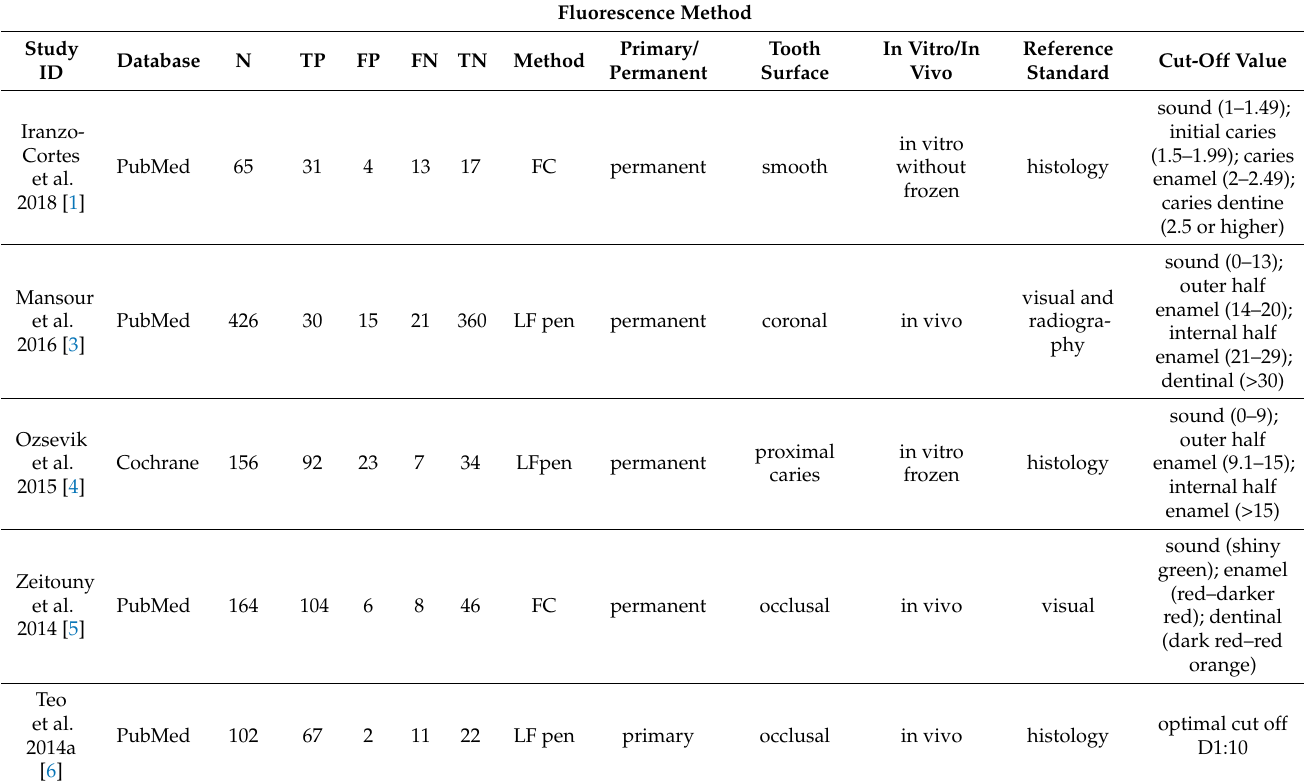
Table A3. Summary of characteristics of included